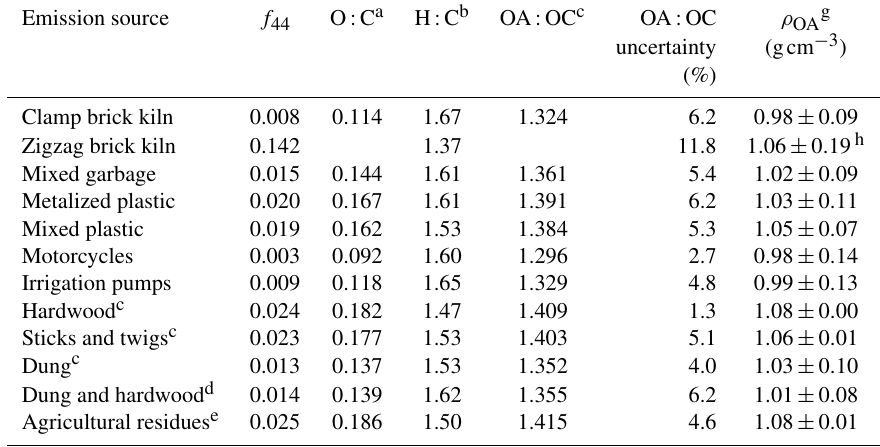
Table 2. The f 44 , O : C, and OA : OC of the field-tested emission sources. Emission source f